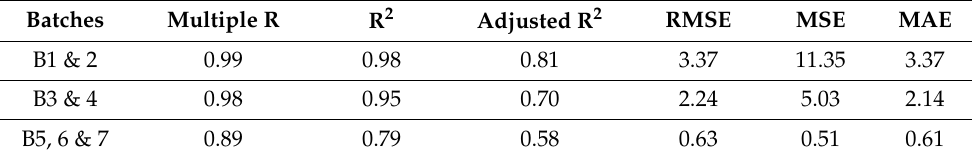
Figure 10. Actual vs. Predicted Concrete CS Values with Testing Dataset. Table 8. Compressive Strength Results of the ANN